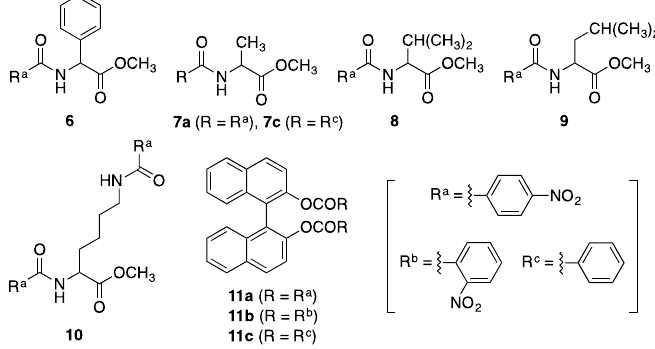
Figure 4. Structures of chiral aromatic nitro compounds and their analogs ( 6 – 11 ).